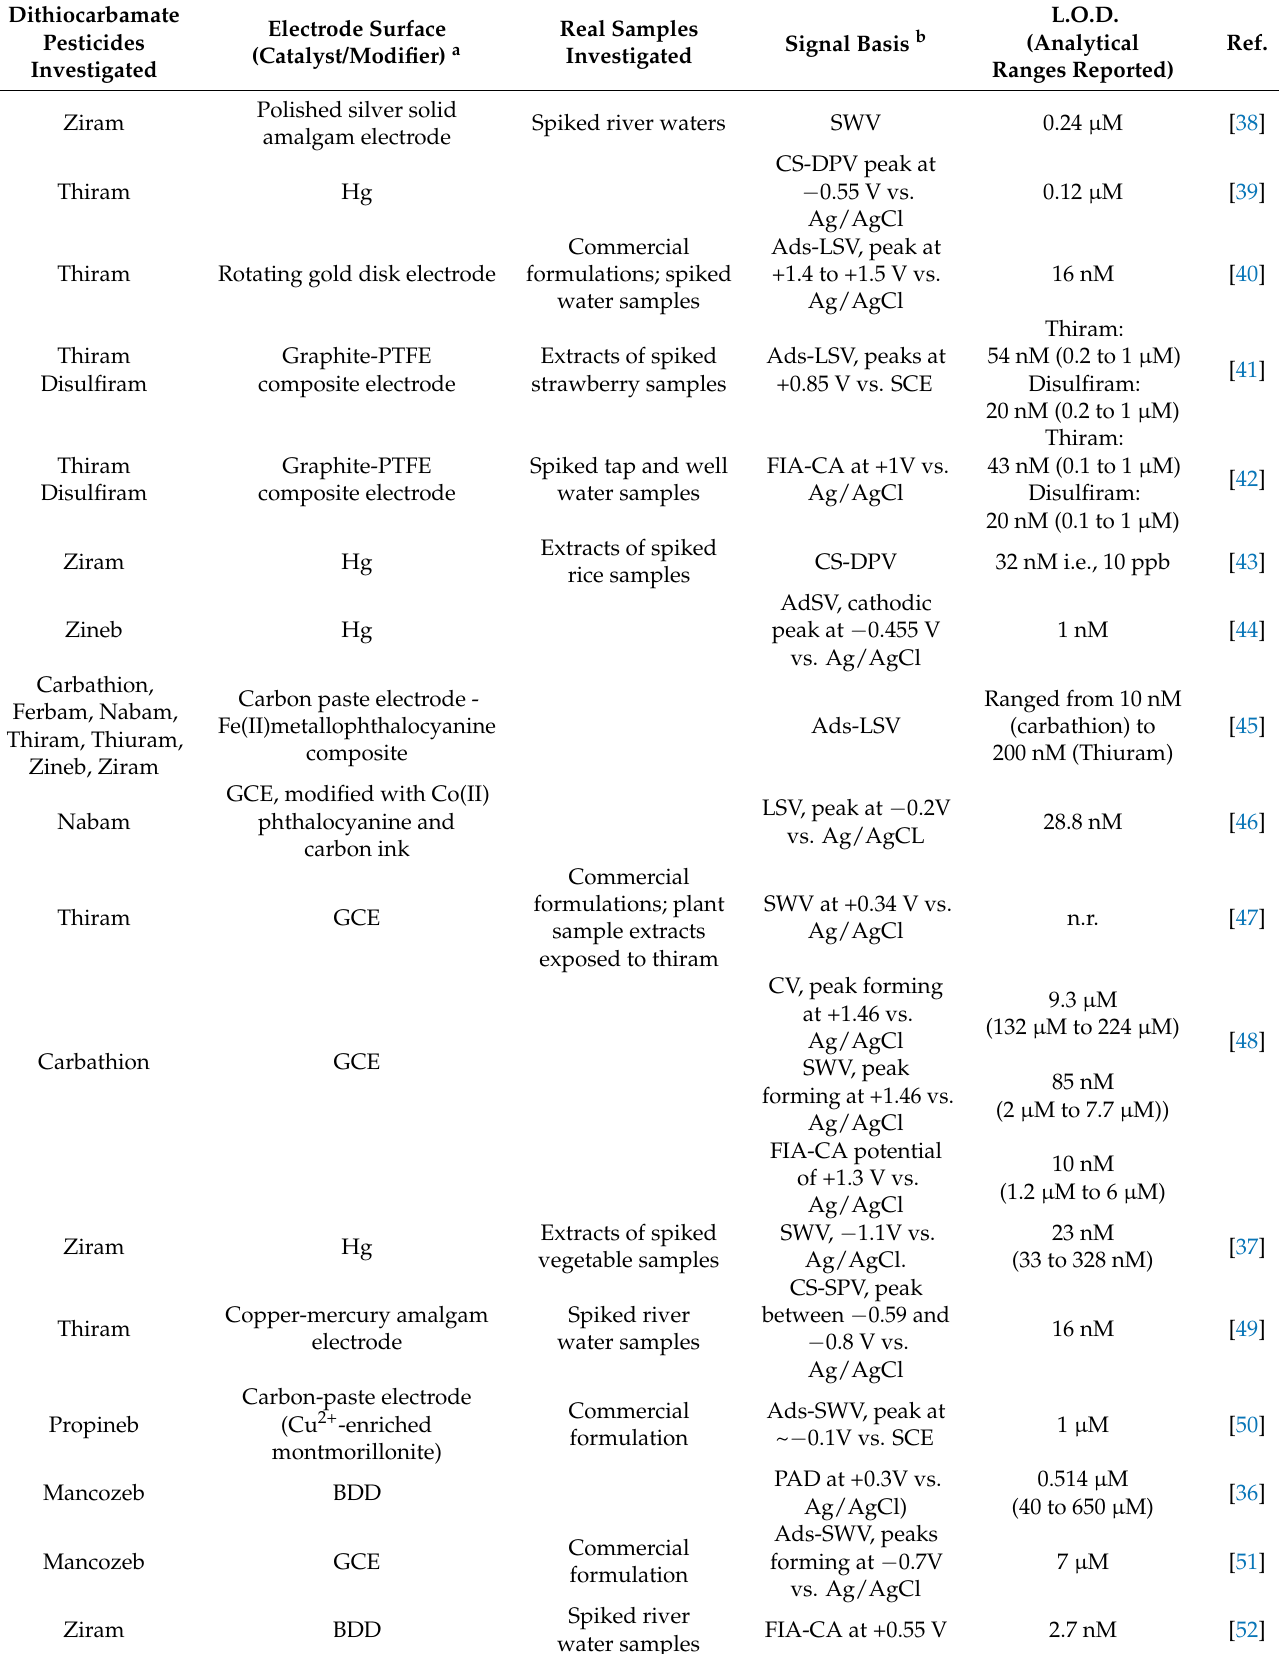
Table 1. Direct electrochemical detection: selectivity via catalysis and/or electrode potential control.